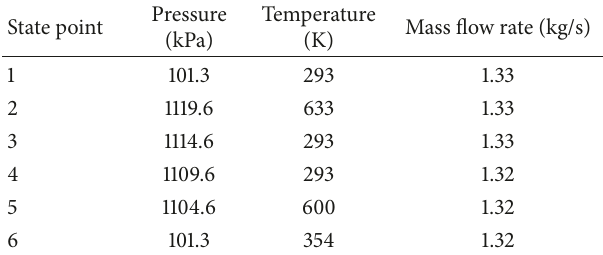
Table 4: Thermodynamic properties and mass flow rates of air at different state points for isothermal OCAES system (see Figure 3 for state points).